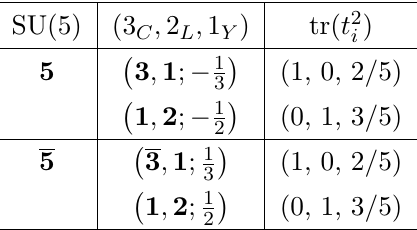
Table 4 . Decomposition of the complex 10 representation under SU(5) and one-loop coe(cid:14)cients.